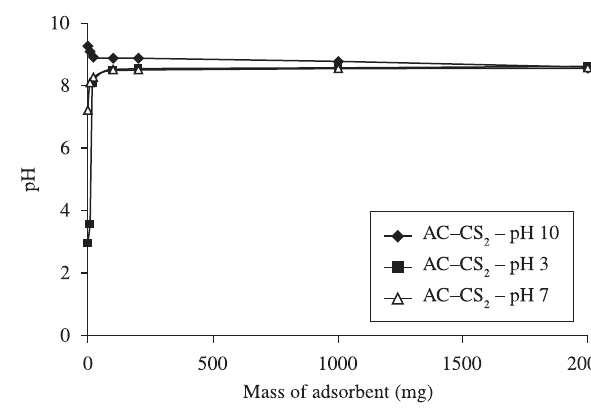
Figure 4. Point of zero charge of AC-CS